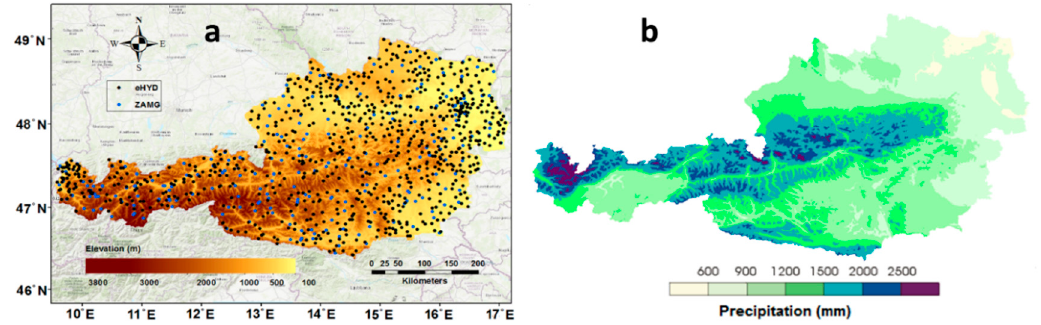
Figure 1. ( a ) Distribution of eHYD and ZAMG precipitation stations and ( b ) mean annual precipitation over Austria.